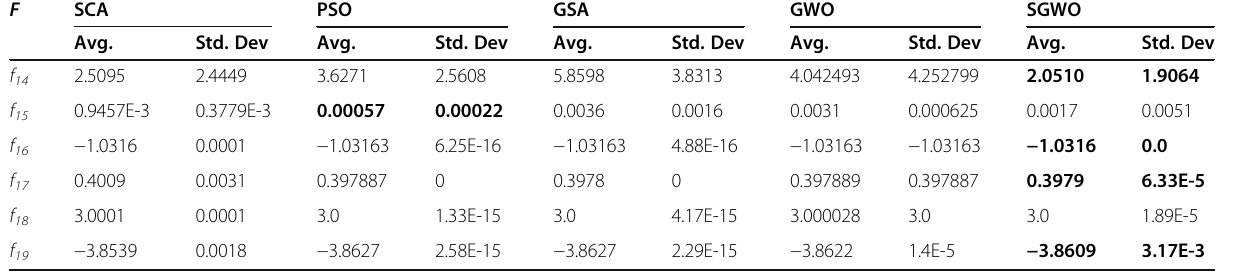
Table 3 Comparison of proposed SGWO with other techniques for fixed-dimension test functions F SCA PSO